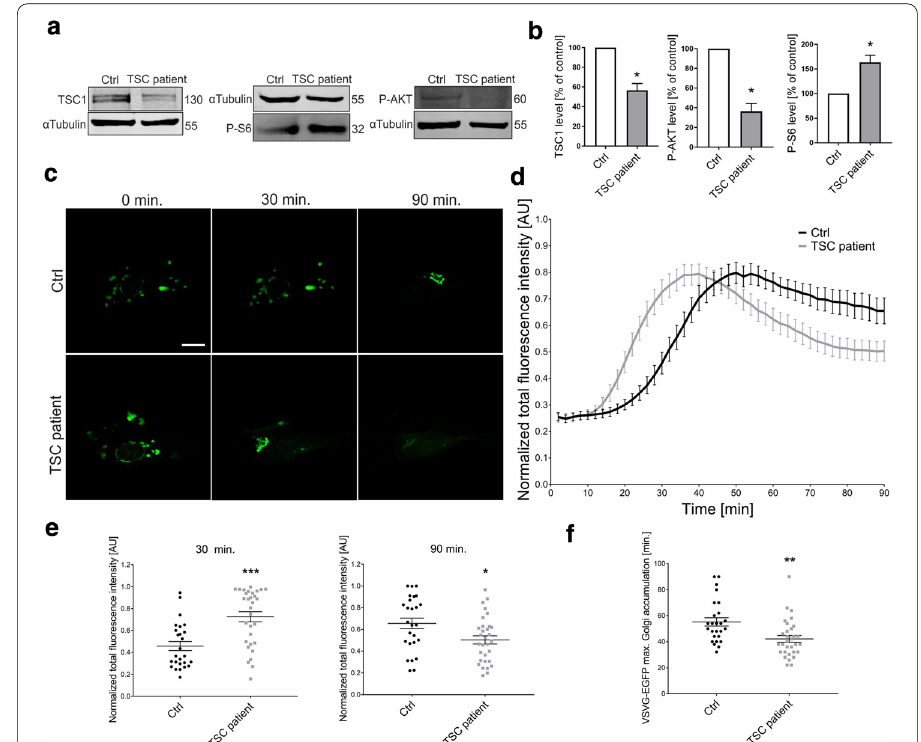
Fig. 5 ER-to-GA VSVg trafficking is affected in fibroblasts from a TSC patient. a Western blot analysis of TSC1, phospho-S6 (P-S6), and phospho-AKT (P-AKT) levels in protein lysates from control fibroblasts (Ctrl) and fibroblasts from a TSC patient. b Quantification of Western blot analysis of P-AKT, P-S6, and TSC1, normalized to tubulin, in protein lysates that were obtained as in ( a ). * p < 0.05 (one-sample t -test). N experiments. c Representative time-lapse confocal images of living fibroblasts: control (Ctrl) and from a TSC patient. The fibroblasts were electroporated with Str-li_VSVGwt-SBP-EGFP. Trafficking of VSVg-EGFP was visualized using the RUSH assay for 90 min after the addition of biotin (time 0). Scale bar d Quantitative analysis of the experiments performed as in c . The graph shows VSVG-EGFP fluorescence intensity in the Golgi apparatus region at each time point, normalized to the maximum value. The data are expressed as the mean for all of the analyzed cells. Error bars indicate SEM. N Number of cells per variant ( n ): Ctrl (26), TSC patient (31). e Comparison of VSVg-EGFP fluorescence intensity in the Golgi apparatus region at 30 min (left panel) and 90 min (right panel). The data are expressed as the mean for all of the analyzed cells. Error bars indicate SEM. * p < 0.05, *** p < 0.001 (Mann–Whitney test). The number of independent experiments and analyzed cells per variant are the same as in ( d ). f Comparison of VSVg-EGFP maximum accumulation times in the Golgi apparatus region. The data are expressed as the mean for all of the analyzed cells. Error bars indicate SEM. ** p < 0.01 (Mann–Whitney test). The number of independent experiments and analyzed cells per variant are the same as in ( d